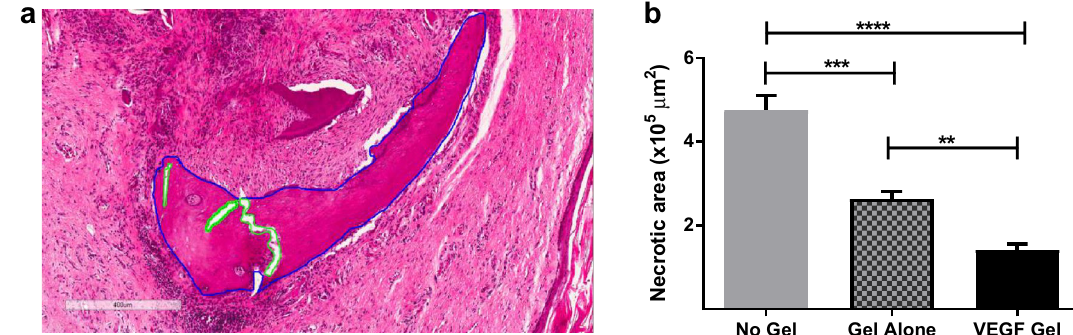
Figure 3. Representative photomicrographs of annotated necrotic area (defect site) with empty lacunae from no-gel group ( a ); quantification of necrotic area ( b ) showed a significant positive effect of the VEGF- gel compared to no-gel and gel-alone groups (****p < 0.0001, ***p < 0.001, **p < 0.01). Blue outlines indicate included areas and green outlines depict excluded areas whilst quantification was performed.